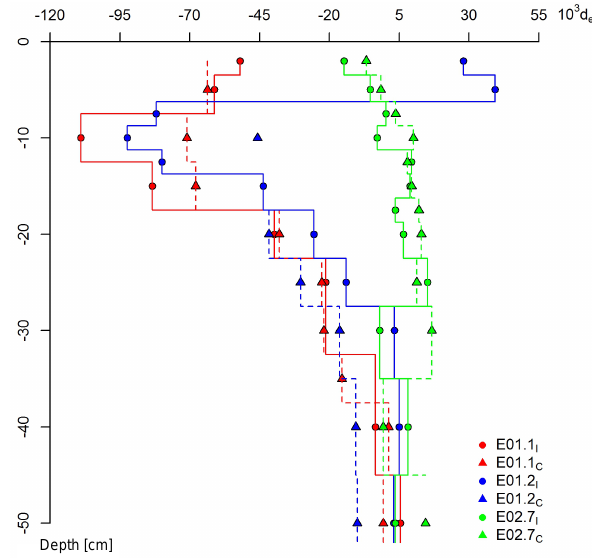
Figure 4. Deuterium excess for profiles E01.1 and E01.2 sampled in June 2014 and E02.7 sampled in November 2014. Compared are values from the cryogenic vacuum extraction (triangles) and the in situ measurements